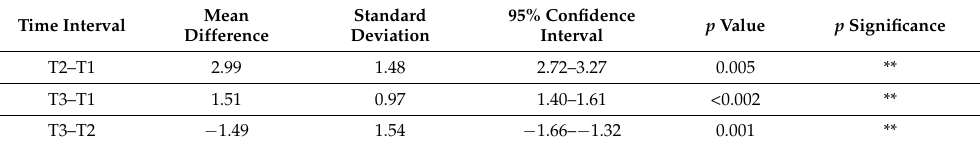
Table 10. Results of the mean differences (mm) of Nasal Floor 9 in the three time intervals.